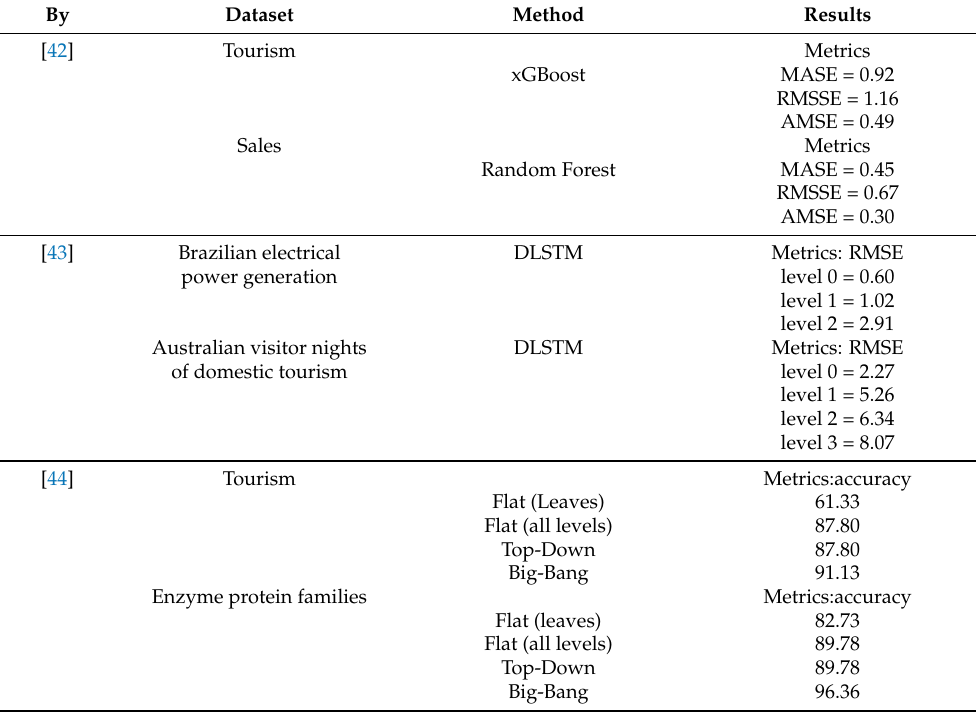
Table 4. Comparison evaluation results with a similar method applied on the time series and enzyme